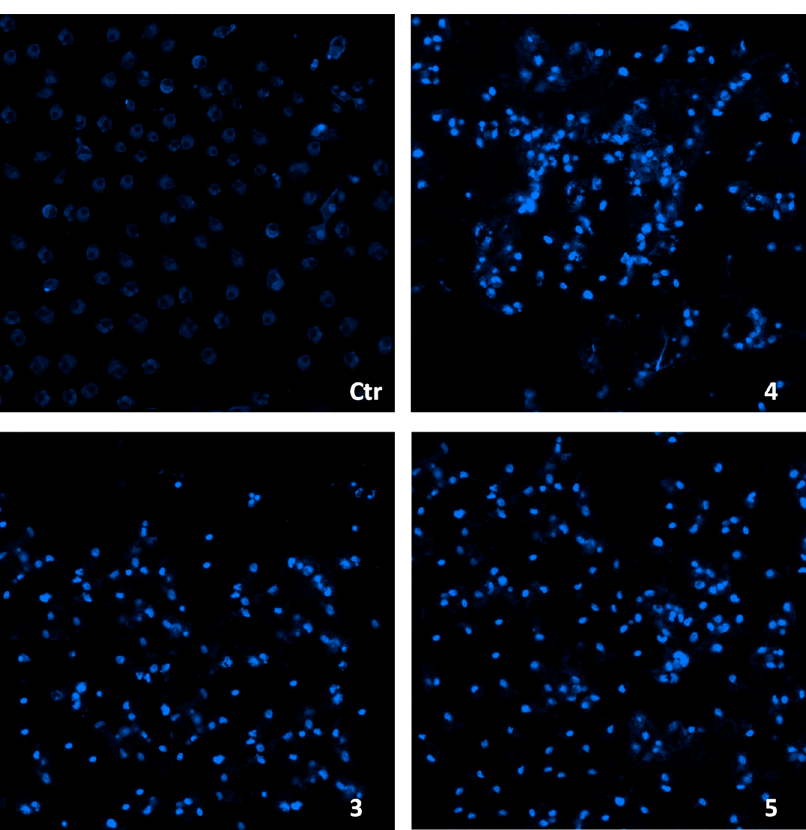
Figure 5. Hoechst staining (magnification, × 20) of U1285 cells incubated for 48 h with IC 50 doses of 3–5 .